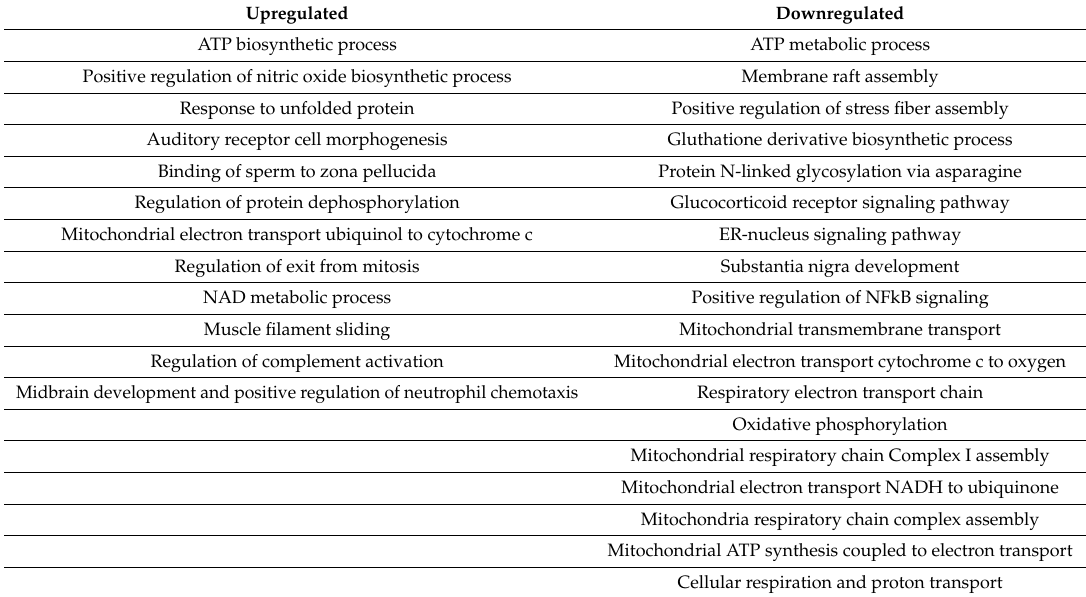
Table 4. List of biological processes related to the mitochondrial-shaping proteins affected in Parkinson’s